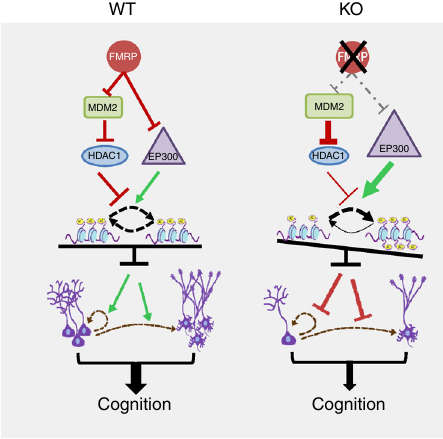
Fig. 10 Models for FMRP maintain histone acetylation through regulating both EP300 and HDAC1 expression levels, which impact adult neurogenesis and